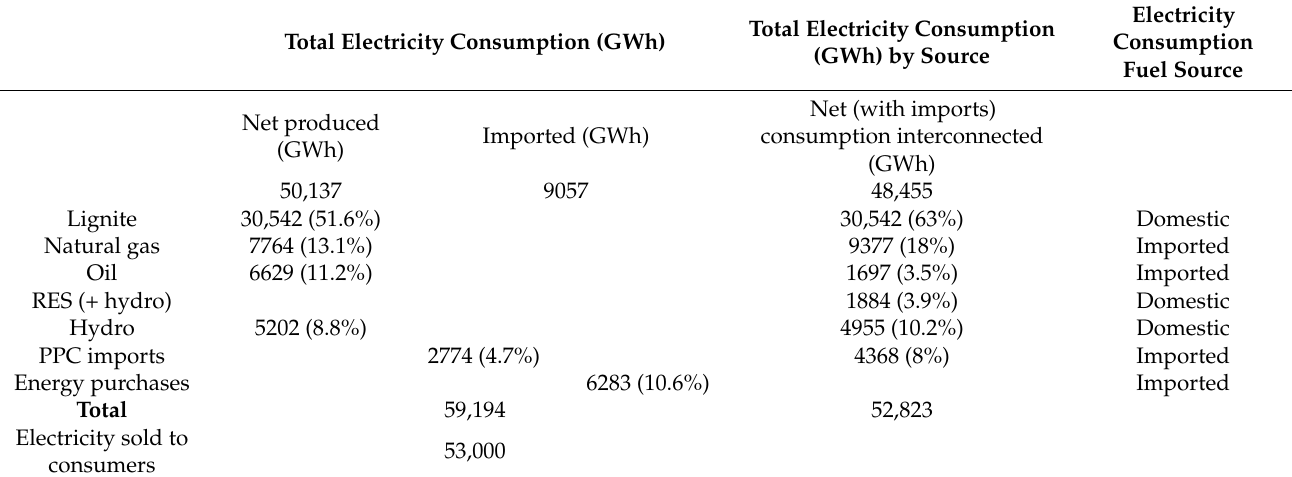
Figure 4. Percentage breakdown of electricity consumption in Greece by energy source, in 2009. Table 1. Electricity consumption and generation analysis in Greece, in